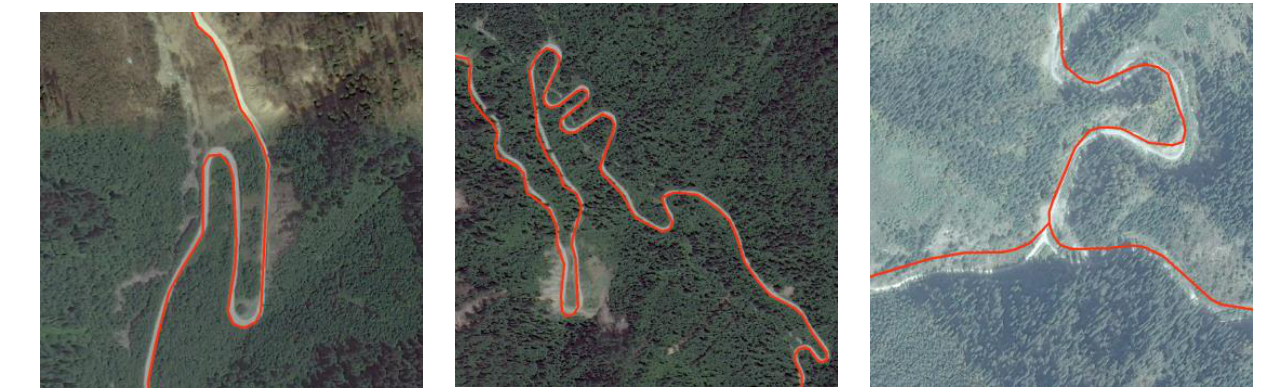
Figure 8. Diagram of OpenStreetMap (OSM) data.